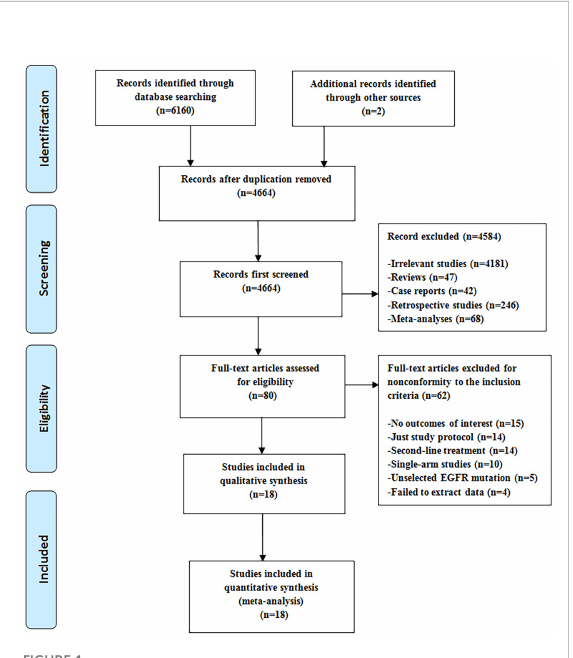
FIGURE 1 Search strategy and follow chat of the included